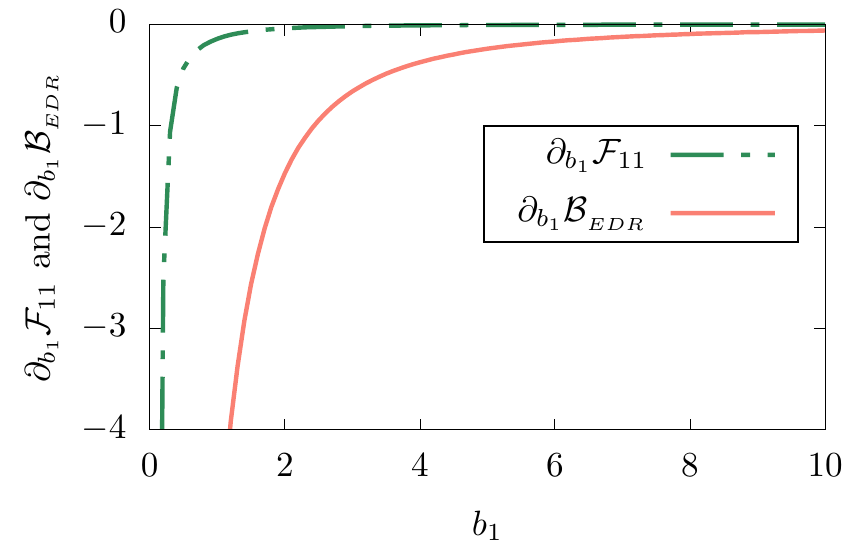
Figure 13 . The derivative of the transition coefficient F 11 (∆ E ) , plotted with respect to varying b 1 for accelerated atoms in thermal background considering Minkowski modes and (1+3) dimensions, denoted by dash-dotted green line. In this figure the quantity ∂ b denoted by the solid